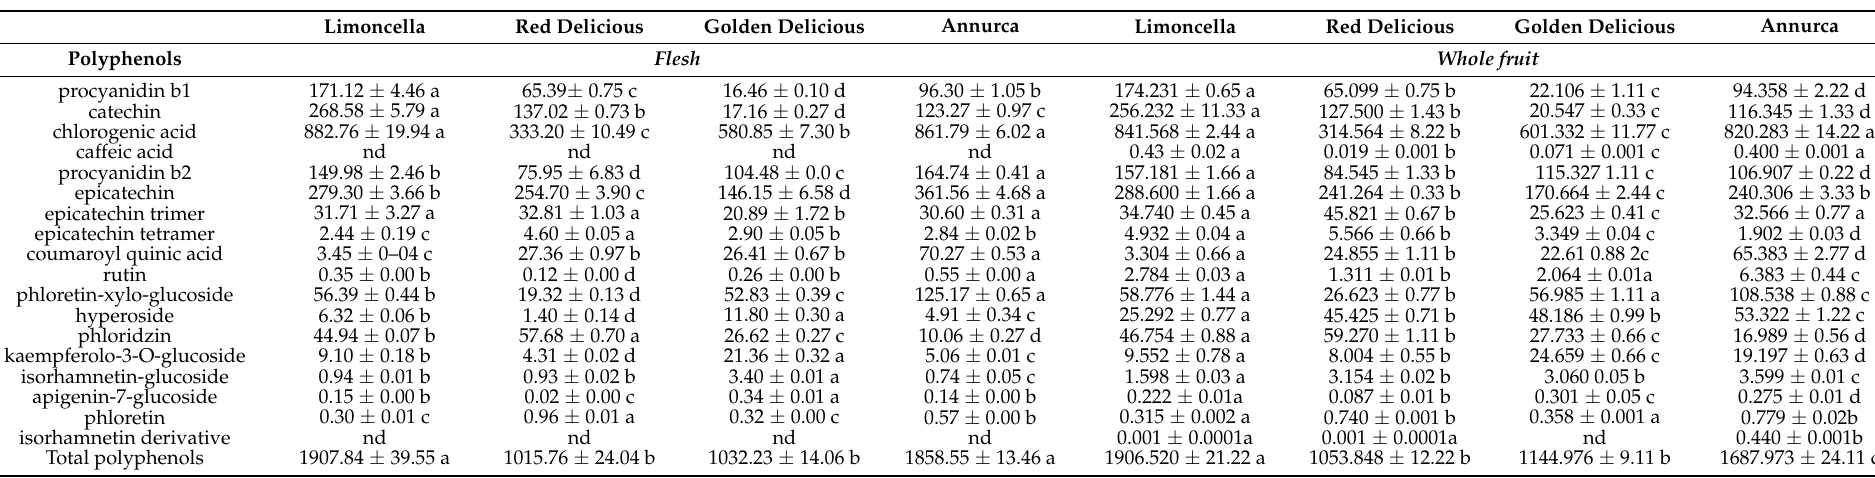
Table 4. Polyphenols content in flesh and whole fruit of “Limoncella,” “Red Delicious,” “Golden Delicious,” and “Annurca” cultivars detected by HRMS-Orbitrap. Values are expressed in µ g g − 1 (dw). Each value represents the mean of three biological and two technical replicates. Different letters denote a significant difference between cultivars within each part (flesh and peel) by analysis of variance [ANOVA]. Statistical significance was defined as p < 0.05, using Tukey’s post hoc test for mean separation. nd: not